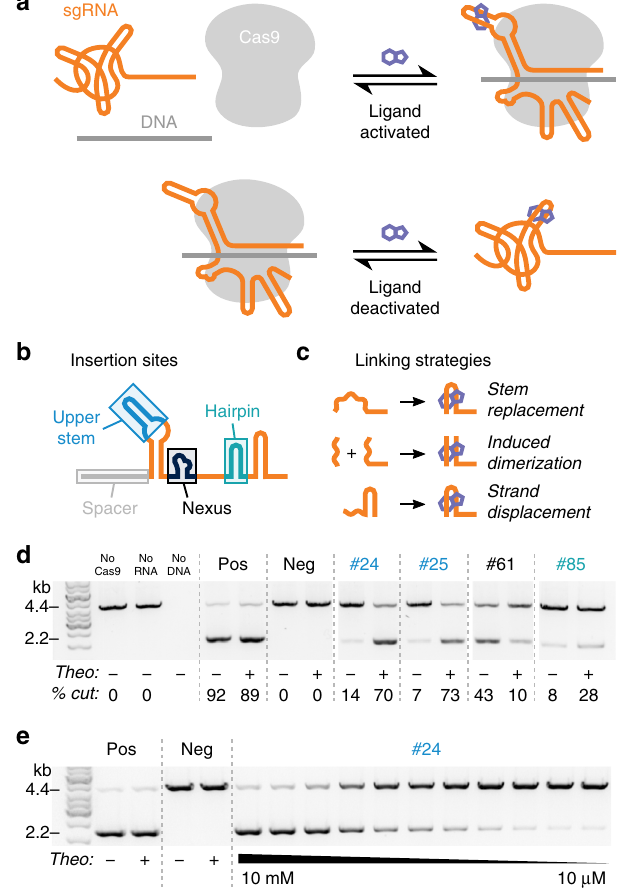
Fig. 1 Design of ligand-controlled sgRNAs by inserting small molecule aptamers into the sgRNA. a Illustration of the design goal, where functional Cas9/sgRNA/target DNA complexes are stabilized either in the presence (top) or absence (bottom) of a small molecule ligand. b Aptamer insertion sites; sgRNA domains de fi ned as in ref. 28. c Strategies for linking the aptamer to the sgRNA (Supplementary Table 1). d Ef fi ciency of in vitro Cas9 cleavage of DNA in the presence and absence of 10 mM theophylline for controls and selected designs. Design numbers refer to Supplementary Table 1 and are color-coded by aptamer insertion sites de fi ned in b . Percent cut values (bottom) are the average of at least two experiments. All data shown are from a single gel (some lanes are excluded for clarity). e Dose- dependence of cleavage ef fi ciency in response to increasing concentrations of theophylline for a representative design (#24). Source data are available in the source data fi